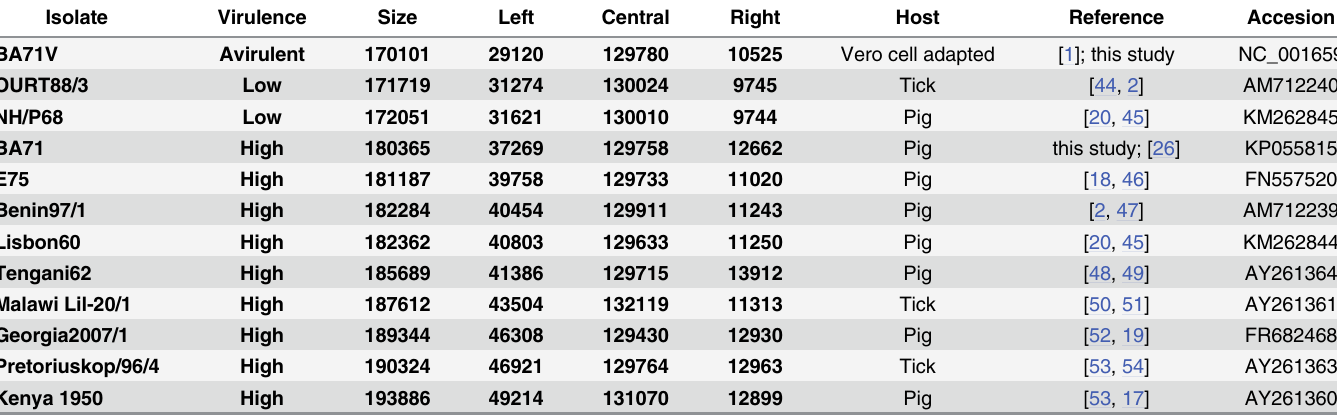
Table 1. Genomic sequences used in this study.